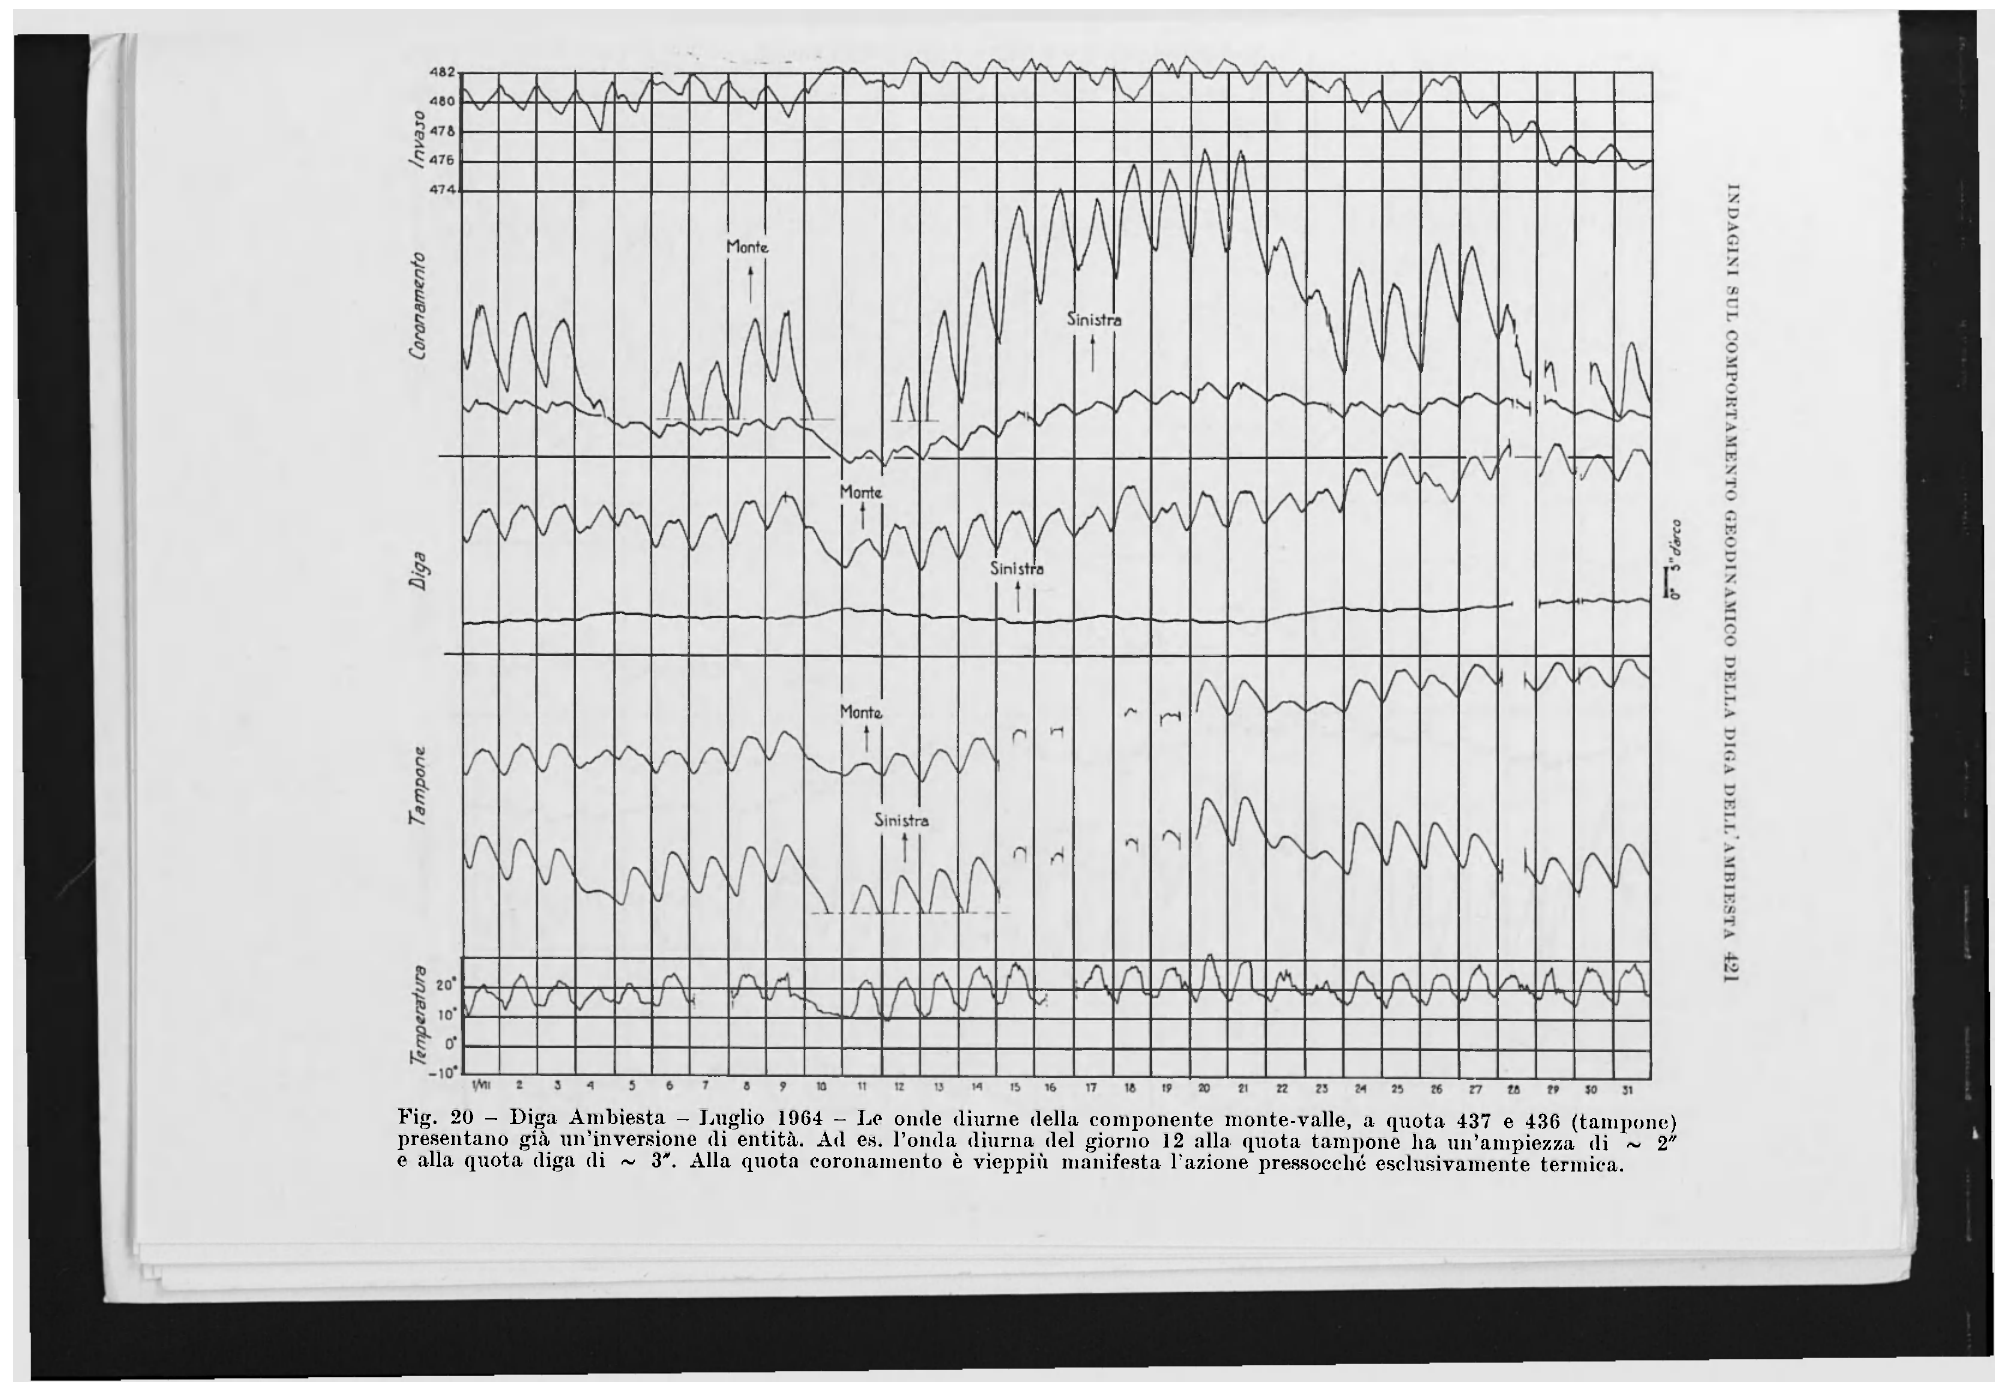
Fig. 20 - Diga Ambiesta - Luglio 1964 - Le onde diurne della componente monte-valle, a quota 437 e 436 (tampone) presentano già un'inversione di entità. Ad es. l'onda diurna del giorno 12 alla quota tampone ha un'ampiezza di ~